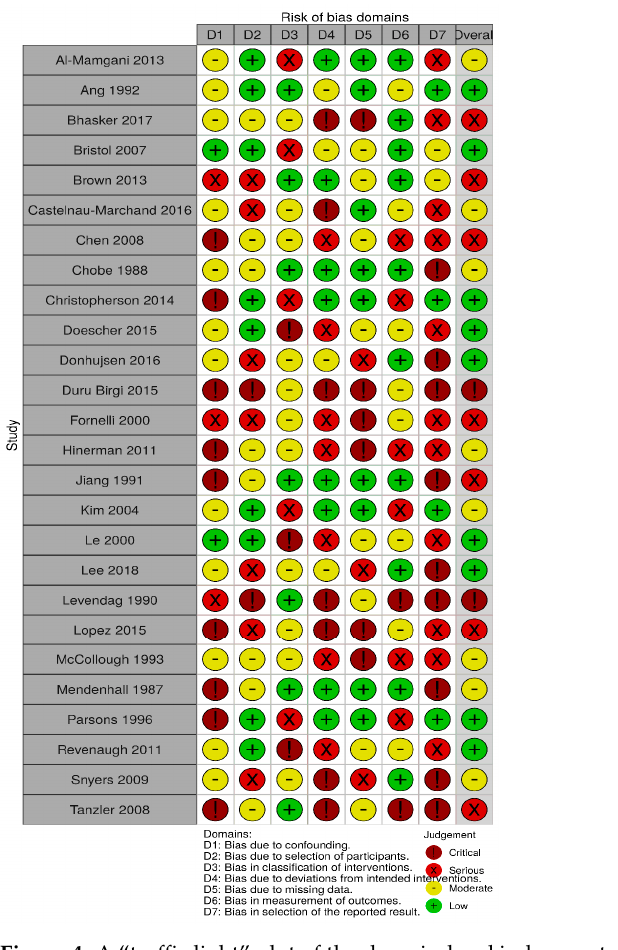
Figure 5. Weighted bar plot of the distribution of risk-of-bias judgements within each bias domain.